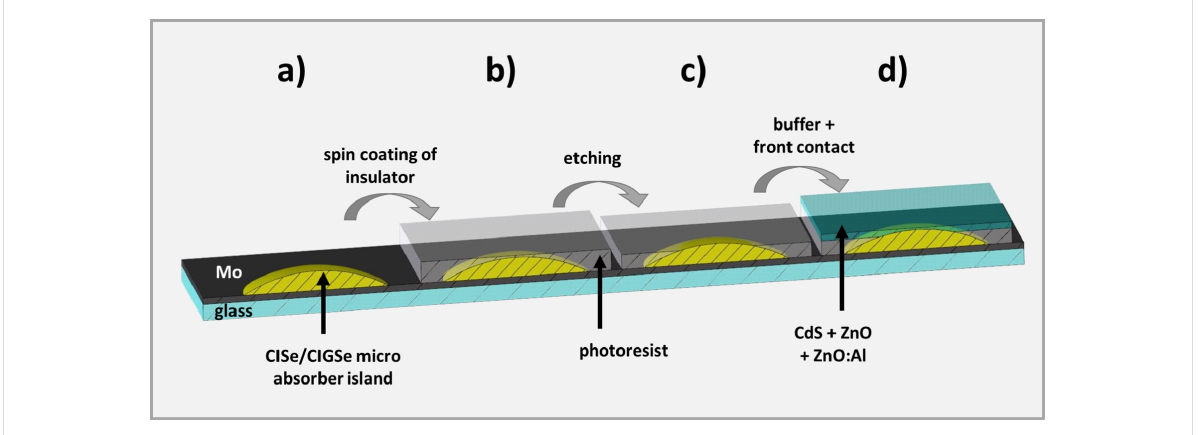
Figure 12: Scheme of the process for manufacturing solar cells from microabsorbers. a) CISe absorber, b) spin coating of photoresist (insulator), c) reactive ion etching in Ar + plasma, and d) addition of CdS and ZnO buffer layers and Al:ZnO front contact.